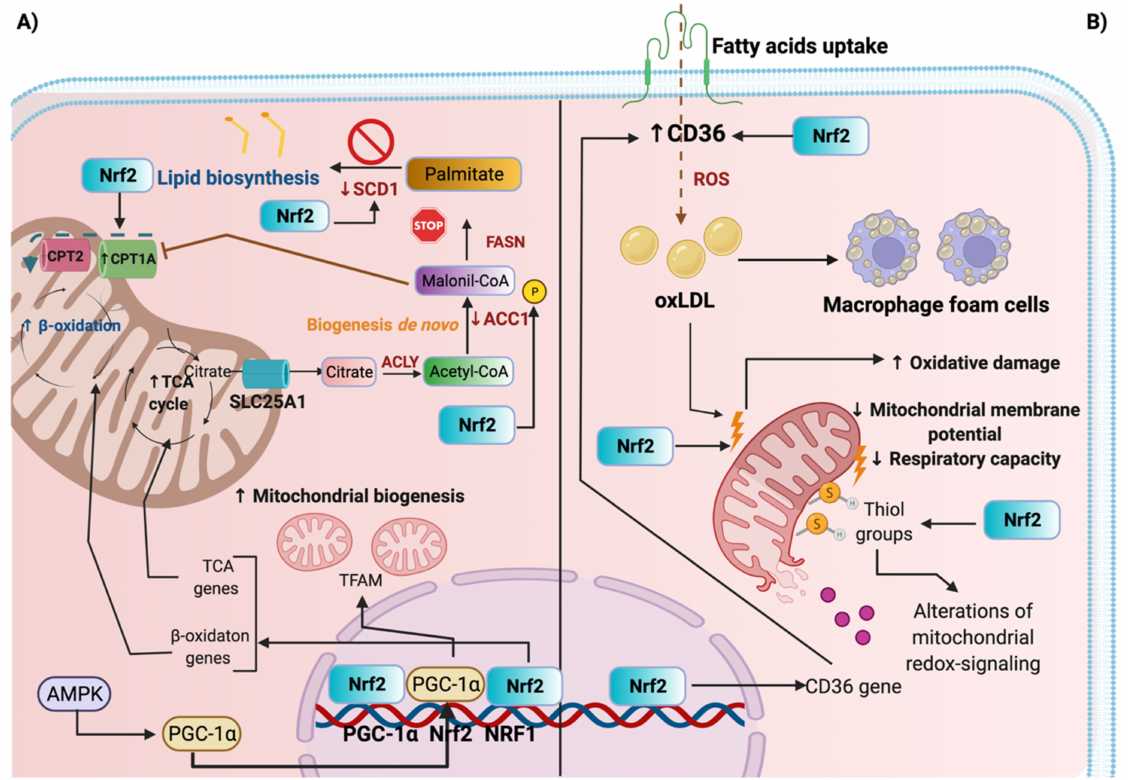
Figure 4. Nuclear factor erythroid 2-related factor 2 (Nrf2) activation and mitochondria. ( A ) Nrf2 up- regulates fatty-acid catabolism via β -oxidation, a process occurring in the mitochondria by inducing the expression of carnitine palmitoyltransferase 1 (CPT1), the rate-limiting enzyme in this mechanism. In contrast, Nrf2 inhibits acetyl-CoA carboxylase 1 (ACC1) via phosphorylation, preventing lipid biosynthesis. Furthermore, Nrf2 inhibits stearoyl-CoA desaturase. Nrf2 also induces the